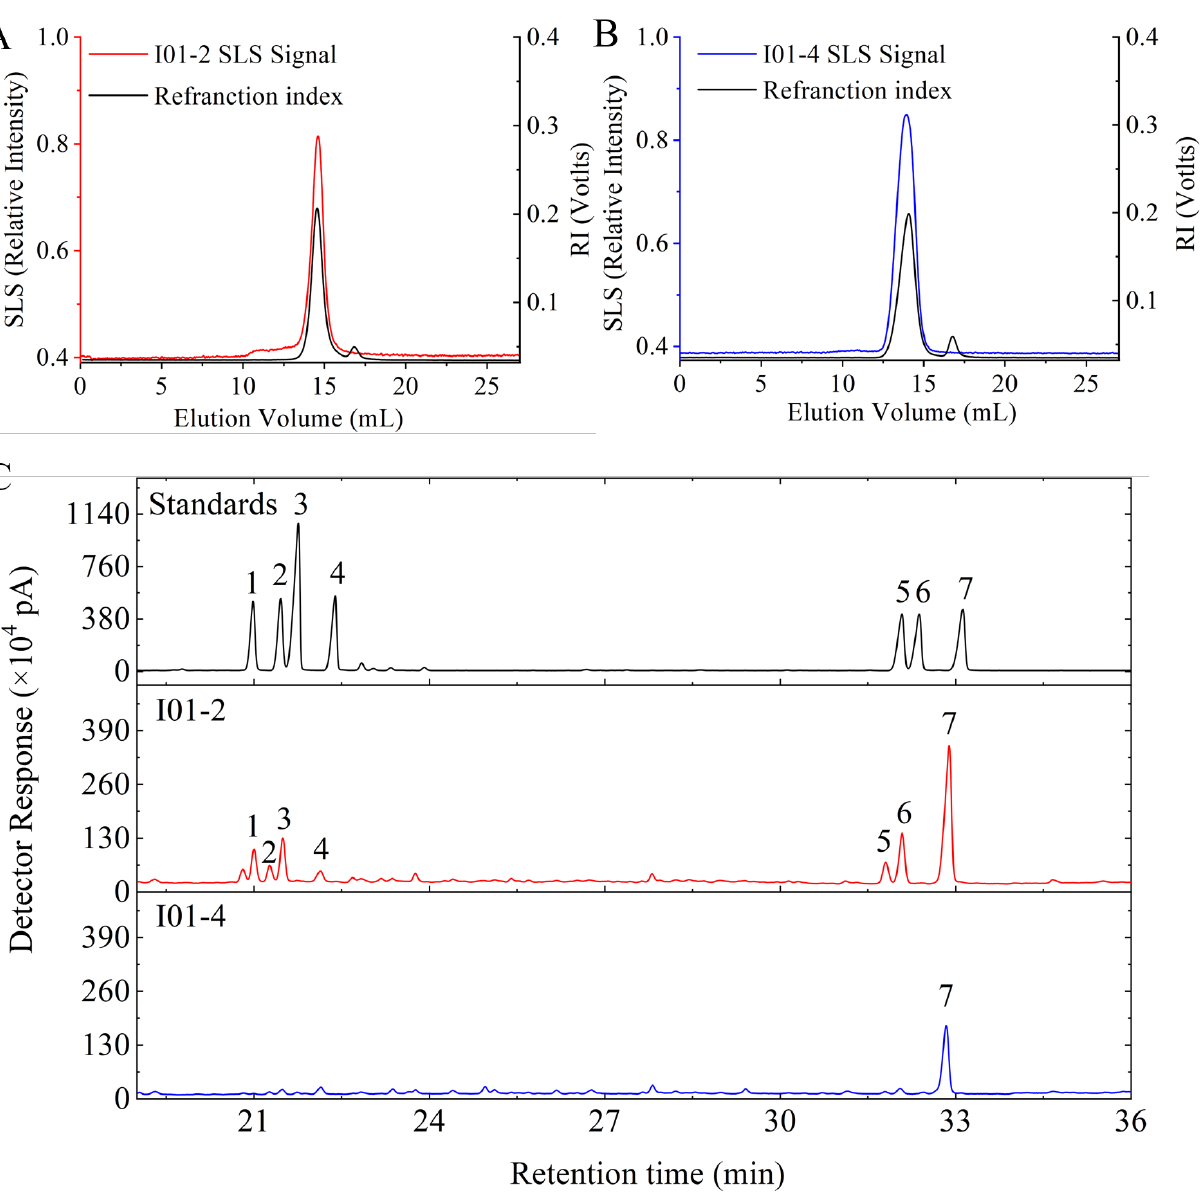
Figure 2. SEC-LLS analysis of I01-2 ( A ) and I01-4 ( B ) and GC chromatograms of the monosaccharide composition ( C ).